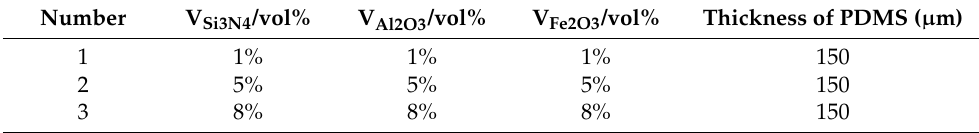
Table 1. Different volume fractions of different particles are added to PDMS.